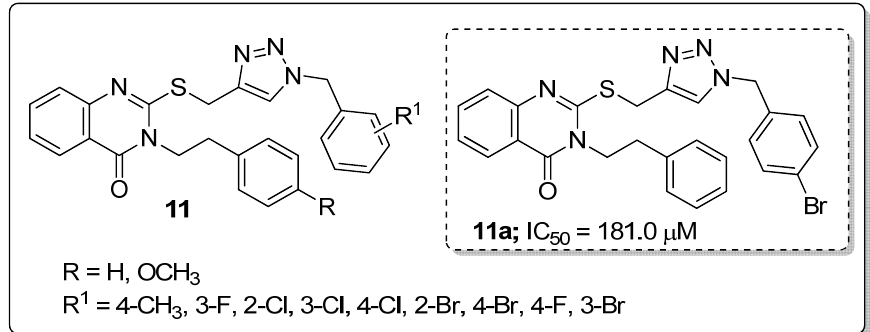
Figure 13. α ‐ Glucosidase inhibitor activity of the most active 1,2,3 ‐ triazole ‐ quinazolinone hybrid 11a .